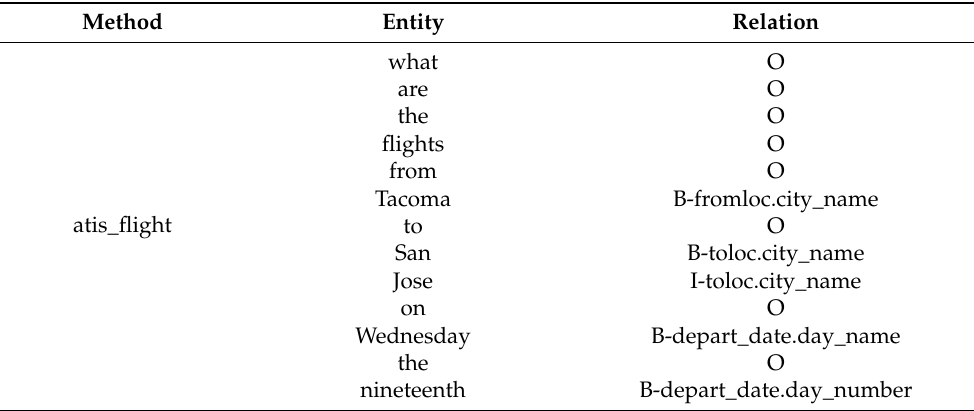
Table 1. An example utterance from the ATIS